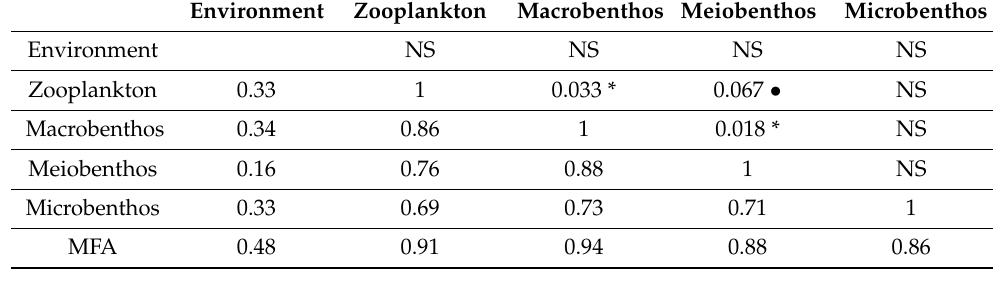
Table 2. Correlation (RV) coefficients (below diagonal, bottom-left half of the table) and corresponding p -values (above diagonal) among the environmental variables, zooplankton and macro-, meio- and microbenthic assemblages (relative abundances, scaled) in the multiple factor analyses (MFA) of water bodies from the Lena River Delta. (NS—not significant, p > 0.1; * 0.01 < p < 0.05; • 0.05 < p < 0.1).